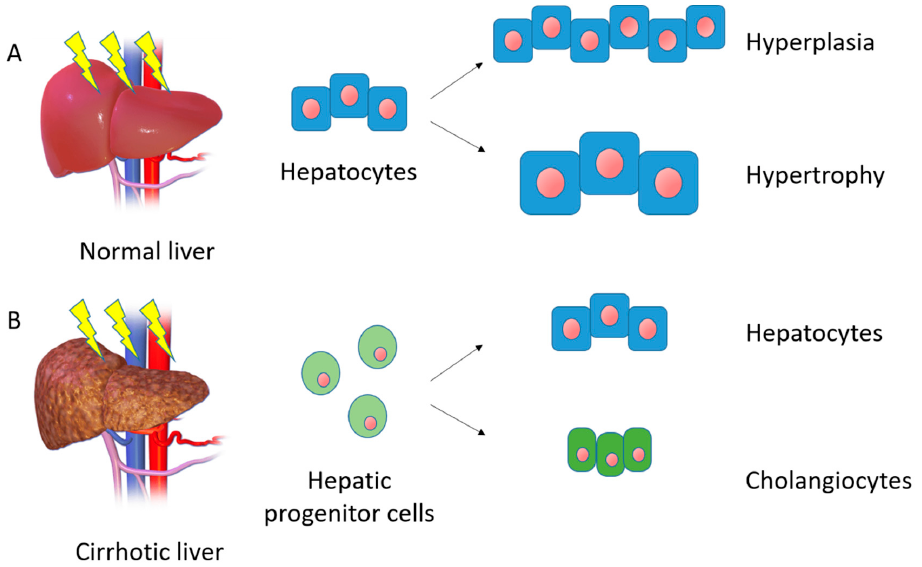
Figure 1. Schematic representation of mechanisms of liver regeneration. ( A ) After liver damage in normal conditions, the principal ways to restore hepatic mass are hyperplasia and hypertrophy. ( B ) In the cirrhotic liver, the normal regeneration process is impaired and hepatic progenitor cells are involved in restoring liver functions.